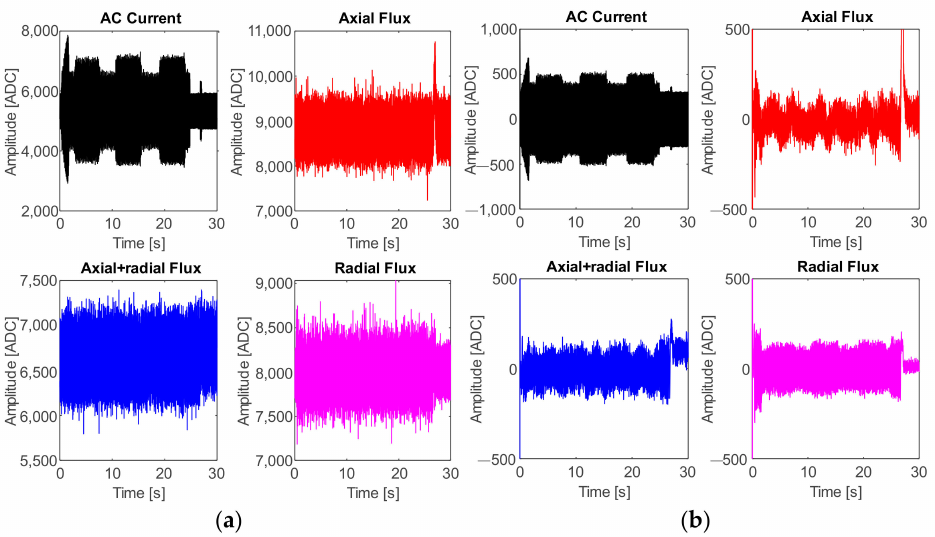
Figure 10. Acquired signals from the four sensors: test taken from variation of cutting speed; ( a ) original signals and ( b ) filtered signals.